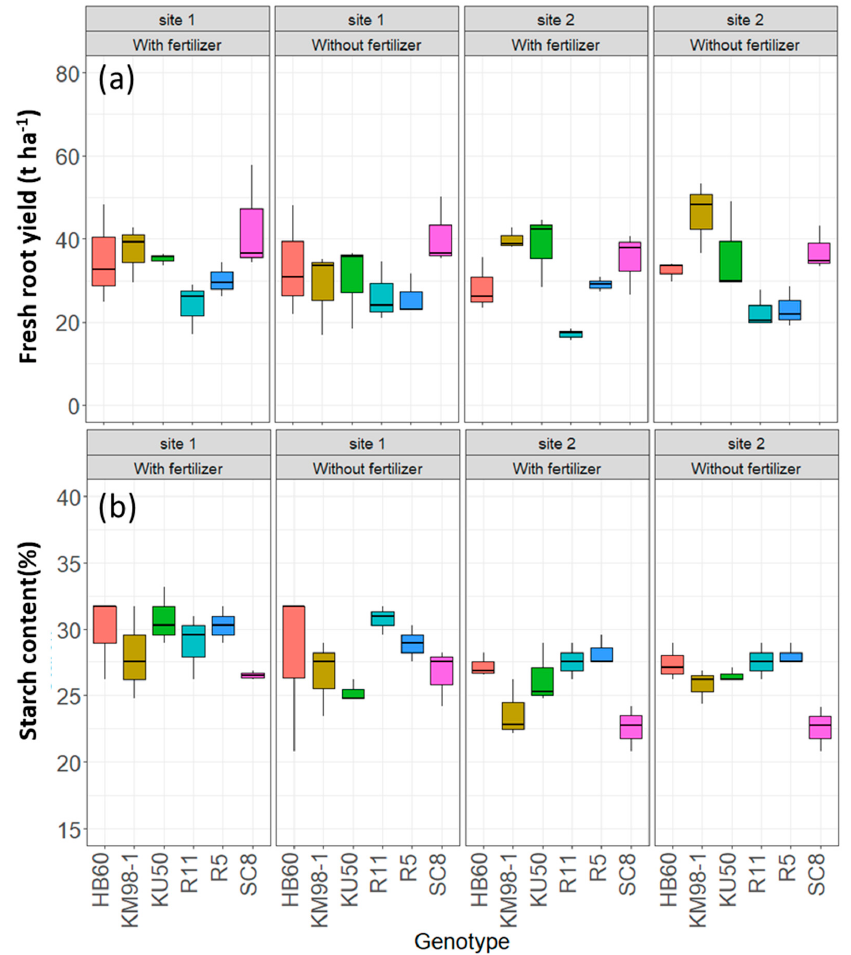
Figure 2. Fresh root yield (t ha − 1 ) ( a ) and starch content (%) ( b ) of six cassava varieties during the 2018–2019 season at two different sites with and without fertilizer. Whiskers indicate the range within a